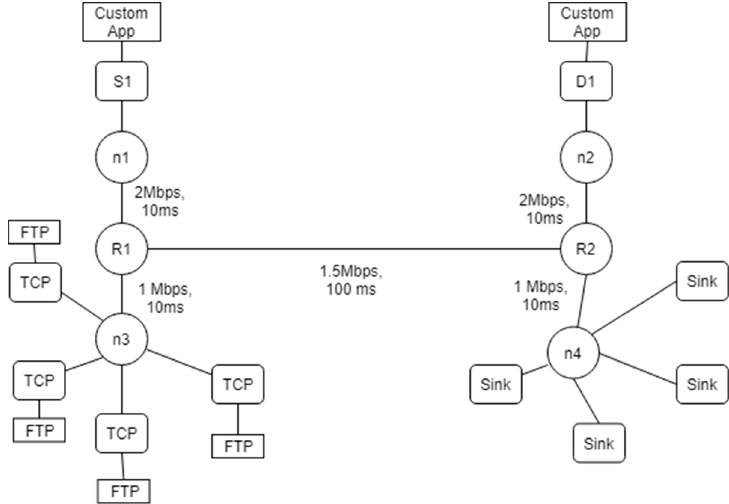
Figure 5. Network topology.